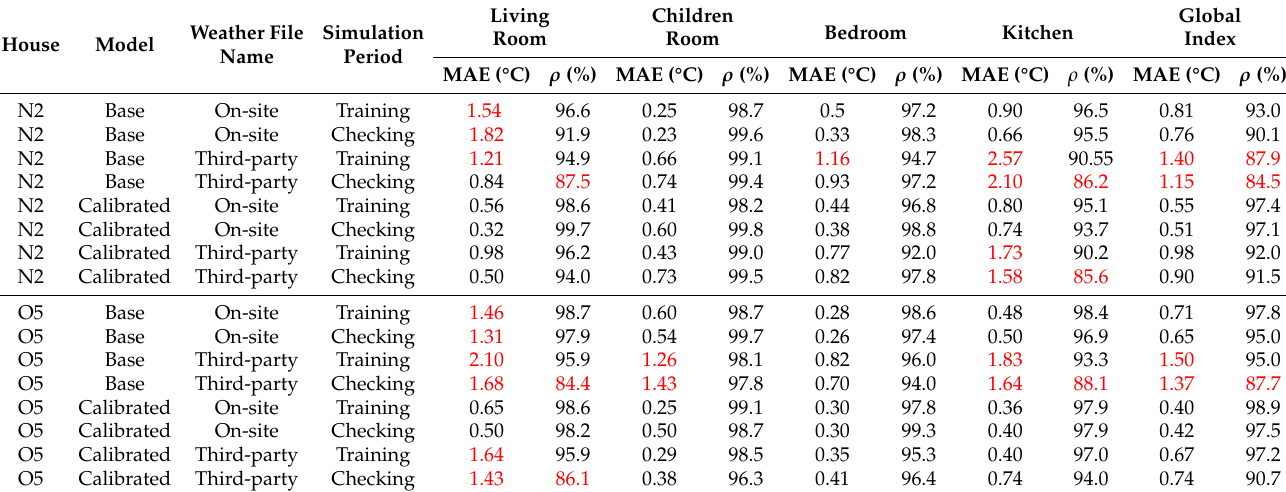
Table 2. Overall adjustment results for the N2 and O5